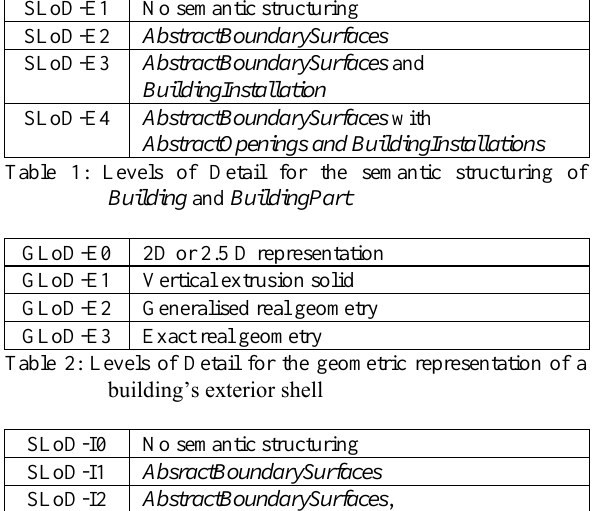
Table 1: Levels of Detail for the semantic structuring of